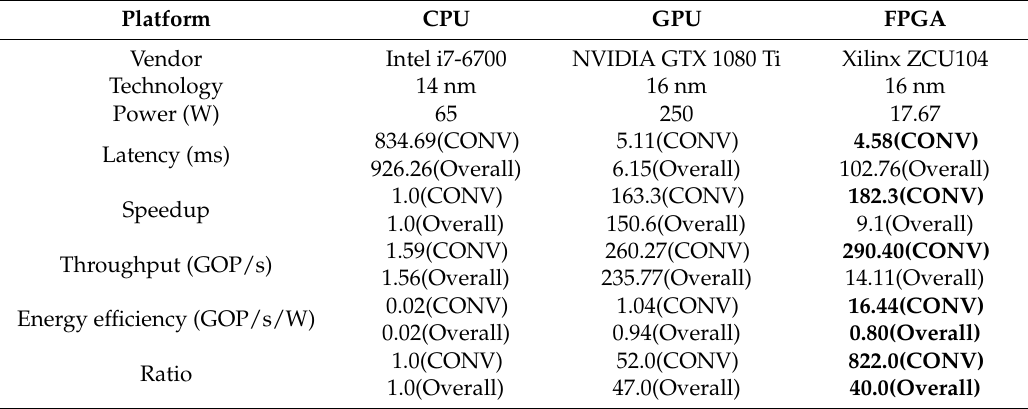
Table 7. Evaluation results on the central processing unit (CPU), graphics processing unit (GPU), and our